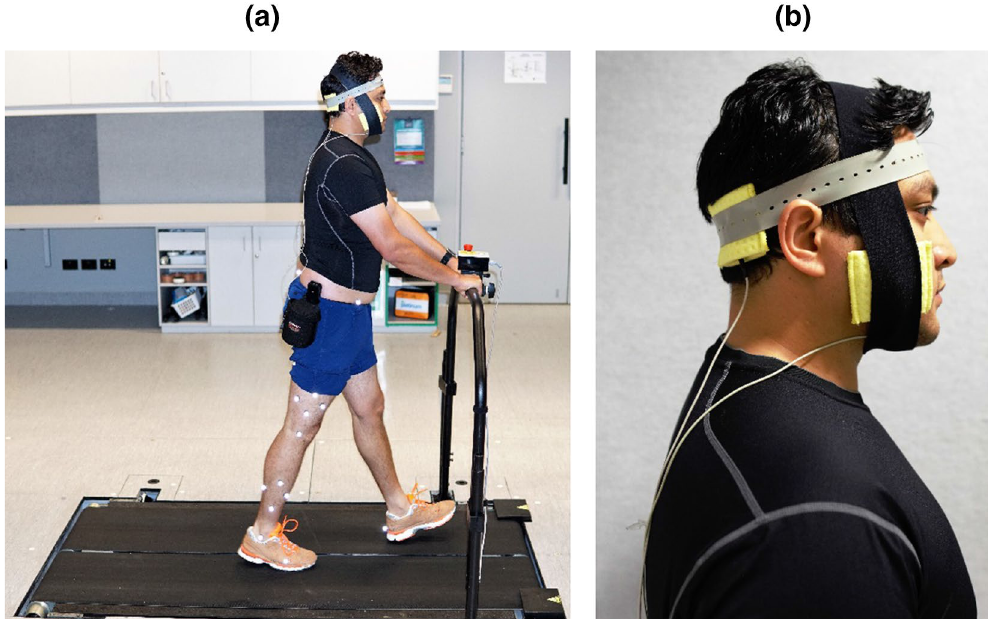
Figure 2. Overview of the experimental setup. ( a ) Participant performing the split-belt treadmill walking task, ( b ) ctDCS electrode